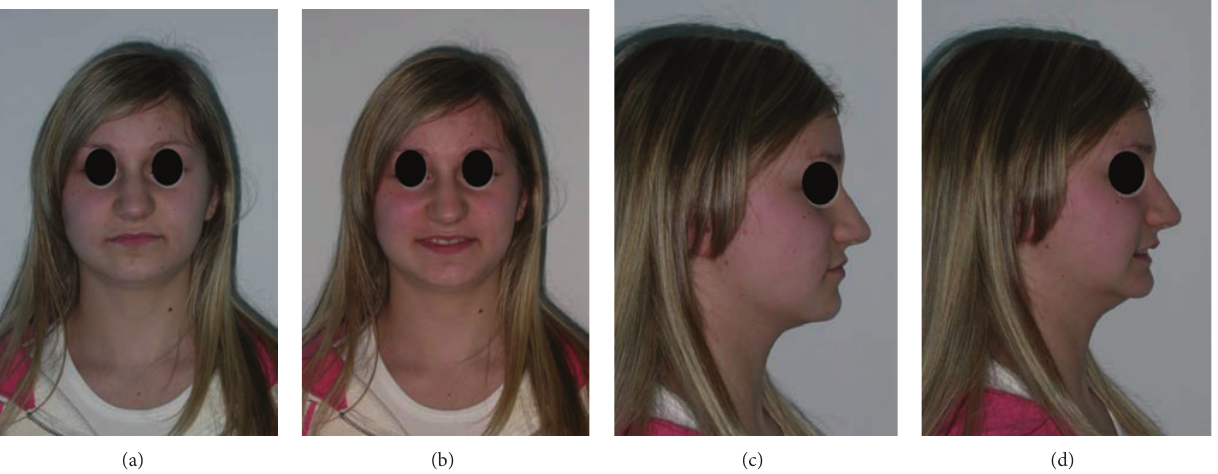
Figure 1: Extraoral photographs before treatment.